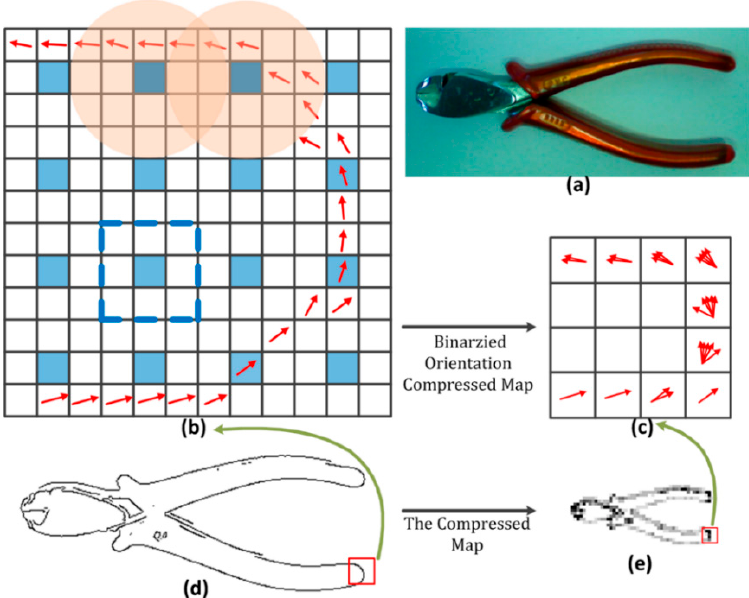
Figure 2. An example to explain the process of producing the binarized orientation compressing map. ( a ) The model image; ( b ) Original quantized gradient orientations in the red box of model edge map; ( c ) The quantized orientation compressing map of Figure 2b; ( d ) The edge map of the model; ( e ) The orientation compressing map of the template image.